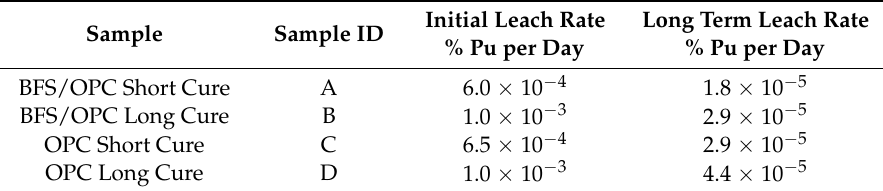
Table 2. Initial and long-term leach rates of 239 Pu from cement